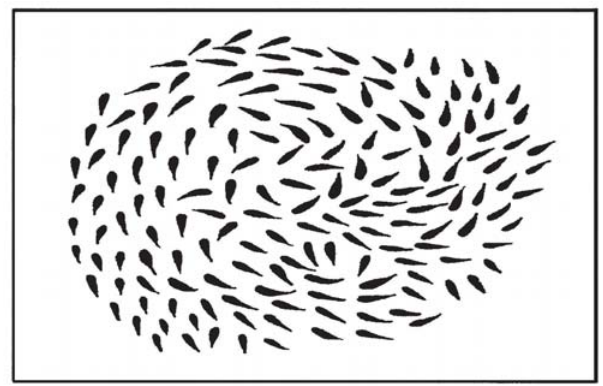
Fig. 1. A stationary school of Mugil curema , composed of small individuals in a shallow shoreline area (observed from the surface). In this situation, the fish are not polarized, and their arrangement resembles a chaotic image.